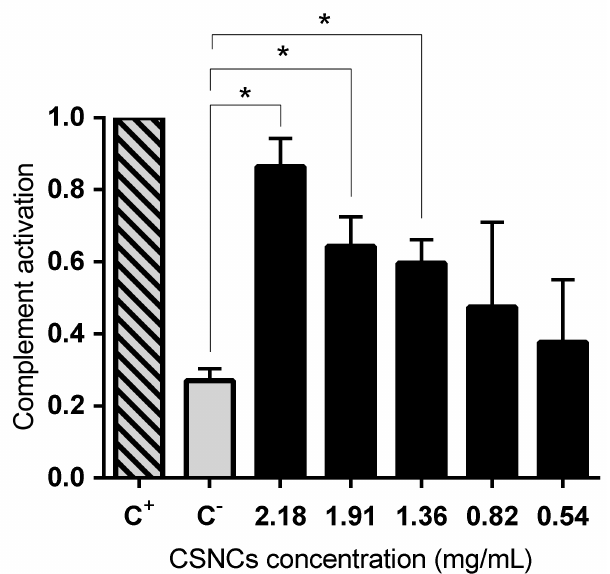
Figure 5. Complement activation of human plasma induced by chitosan nanocapsules (CSNCs). Cobra venom factor (C + ) and dPBS (C – ) were used as positive and negative control respectively. The values were normalized by positive control by giving it a value of 1 (mean ± SD, n = 3) p >